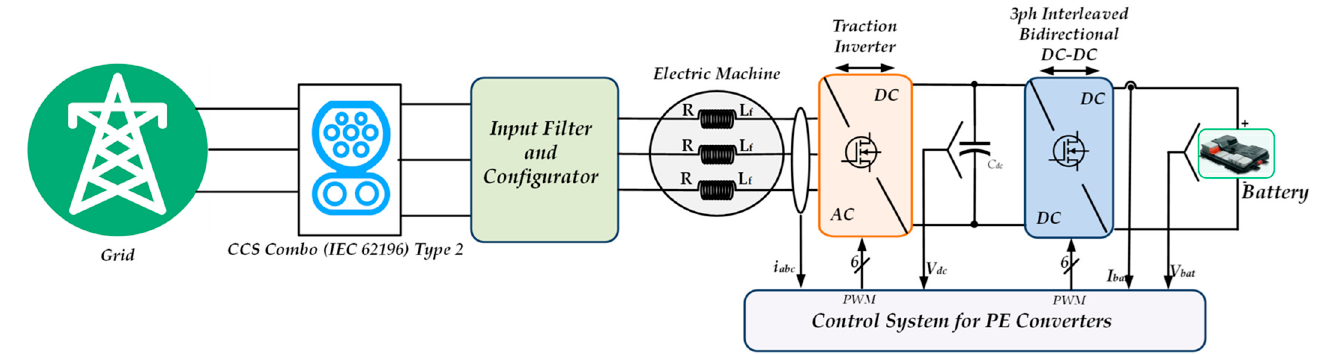
Figure 20. Integrated Power Converter with Control System in Charging Mode.